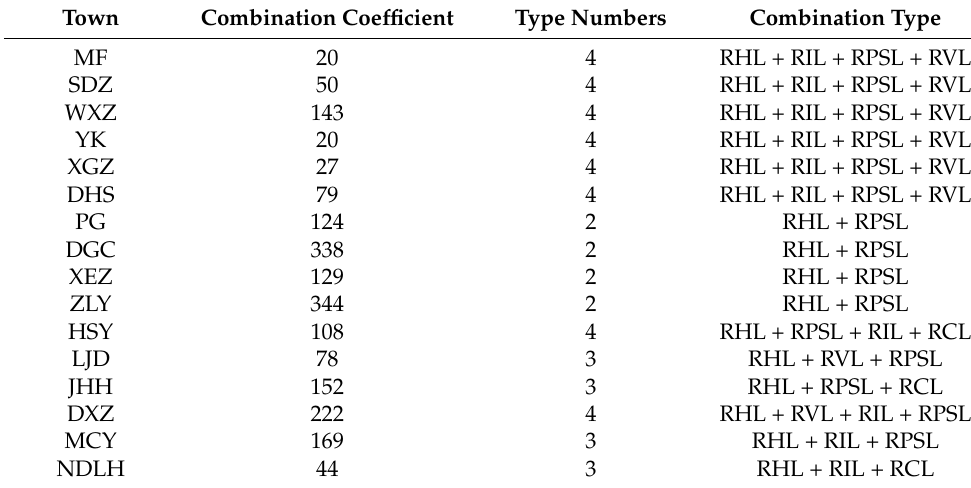
Figure 5. Combination types of the RSILUS in Pinggu District in 2025. Table 2. Combination Type of the RSILUS in Pinggu District in 2025.